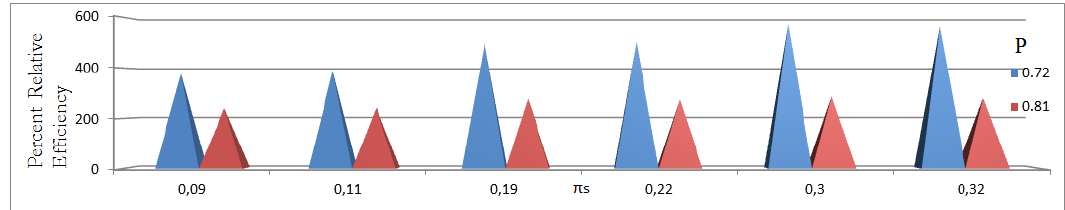
Figure 4 - Percent relative efficiency of the proposed estimator Kim and